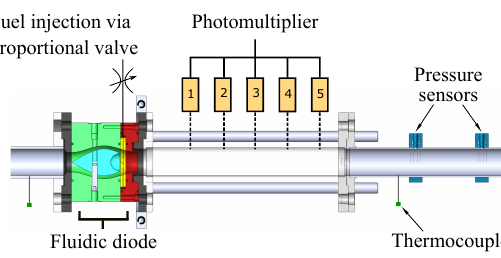
Figure 3. Section view of the injection geometry and combustion tube with